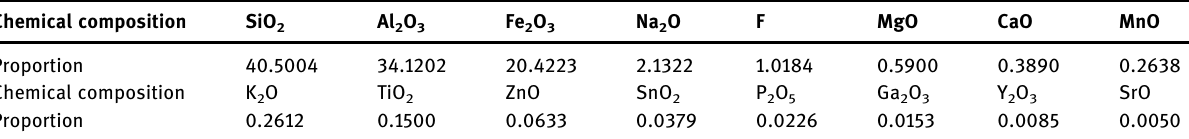
Table 6: Chemical composition of tourmaline powder Chemical composition